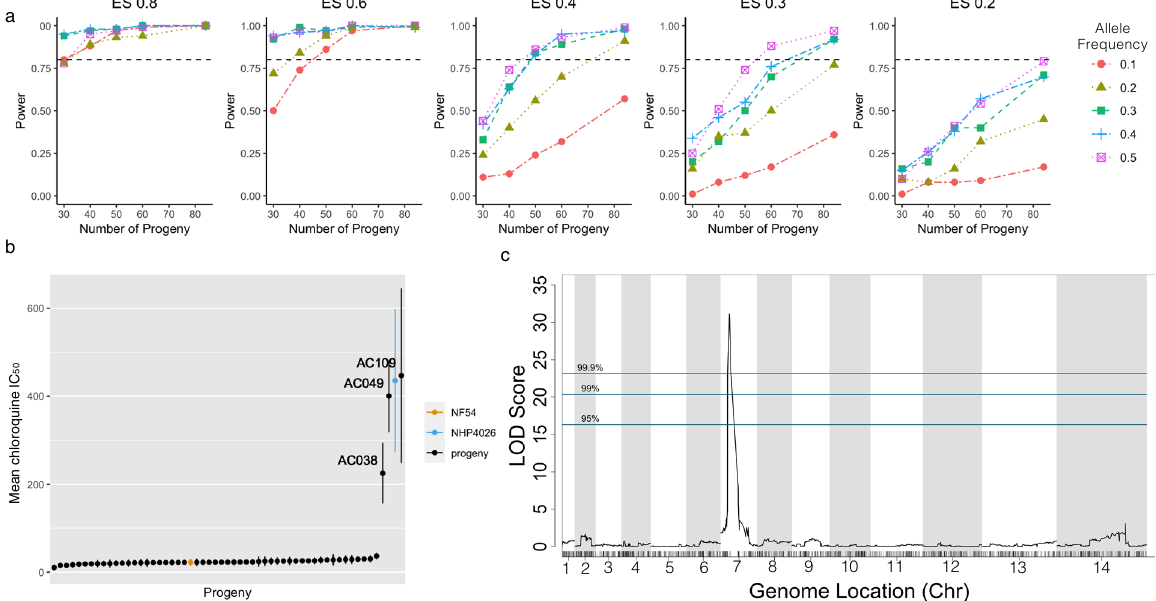
Fig. 7 Power loss due to segregation distortion. a Effect of segregation distortion on mapping power with NF54 × NHP4026 progeny with simulated phenotype data at different ES. Each sub-panel shows the relationship between allele frequency and power for different numbers of progeny at a fi xed ES. For a high ES, allele frequency has little effect on power. At lower ES, we observe a large loss of power for alleles with less than 0.3 allele frequency. b Distribution of mean ± standard deviation of the chloroquine IC 50 from fi ve biological replicates of 56 progeny and two parents from the NF54 × NHP4026 cross. c QTL mapping of mean chloroquine IC 50 (ES = 0.84) in ( b ) results in a LOD score of 31.13 and a genome-wide p value of 0.0007 demonstrating that despite extreme segregation distortion, QTL can be detected for experimental phenotype data with high ES.